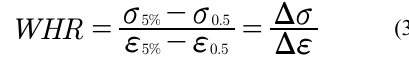
the 3.5 x 10 -4 s -1 strain rate. The peak around 420°C, 3.5